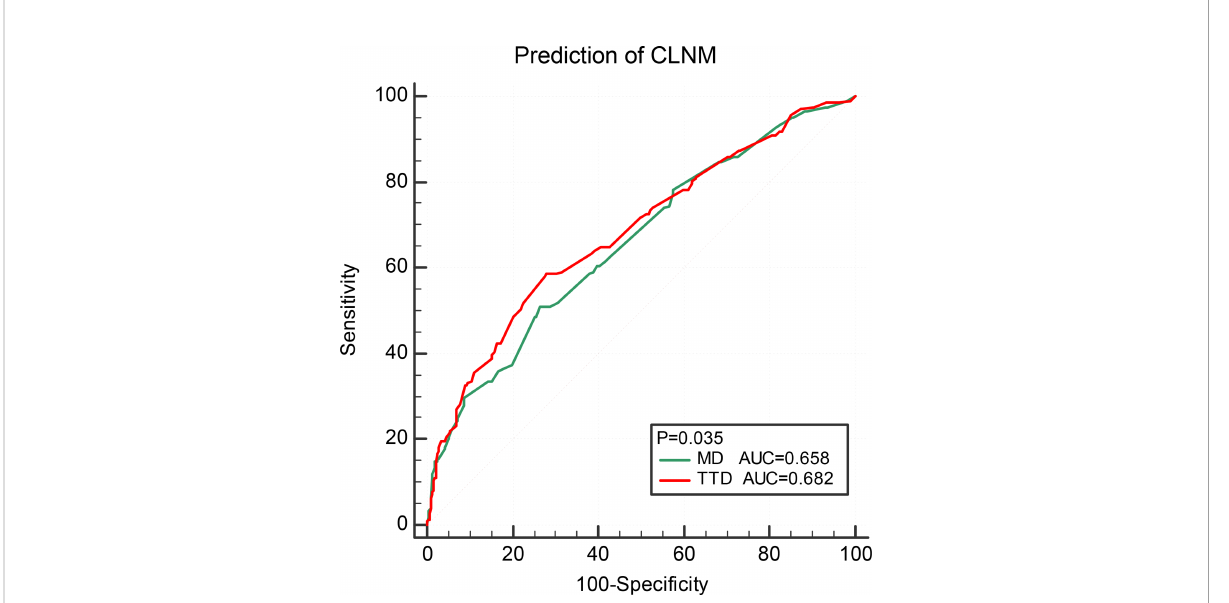
FIGURE 2 Comparison of prediction ef fi ciency of TTD and MD for CLNM. TTD, total tumor diameter; CLNM, central lymph node metastasis; ETE, extrathyroidal